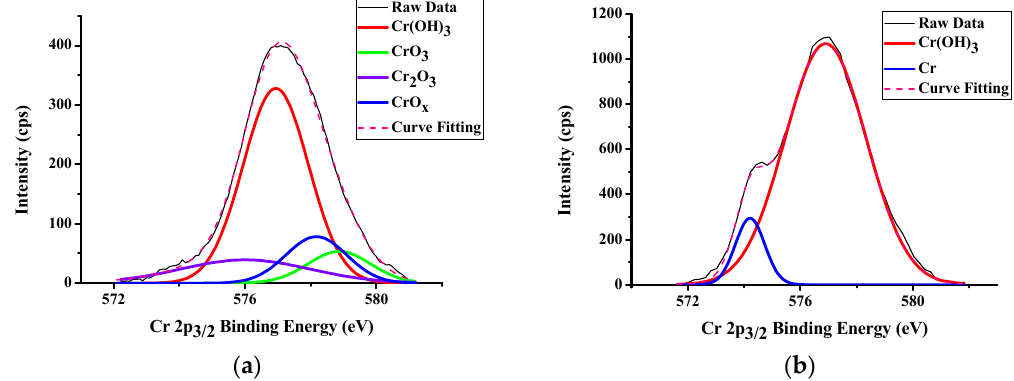
Figure 14. XPS results of Cr ( a ) Before Ar + O 2 plasma treatment ( b ) After Ar + O 2 plasma treatment.